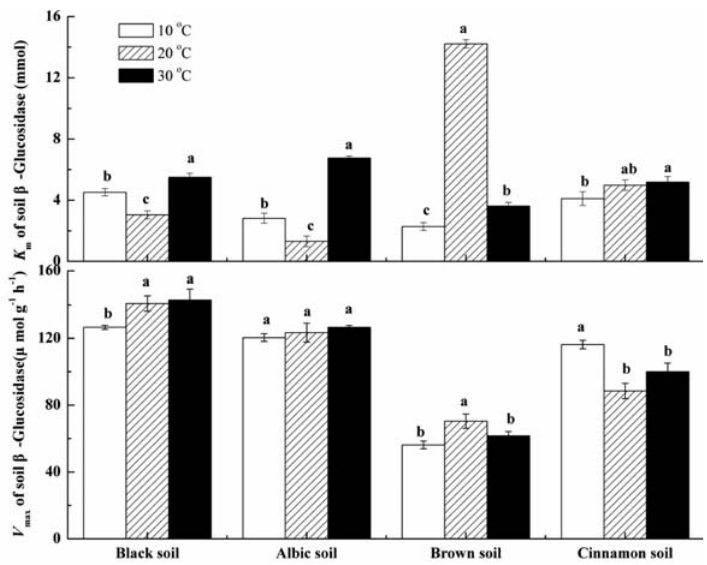
Figure 1. K and V of soil β -glucosidase ( K m max incubated